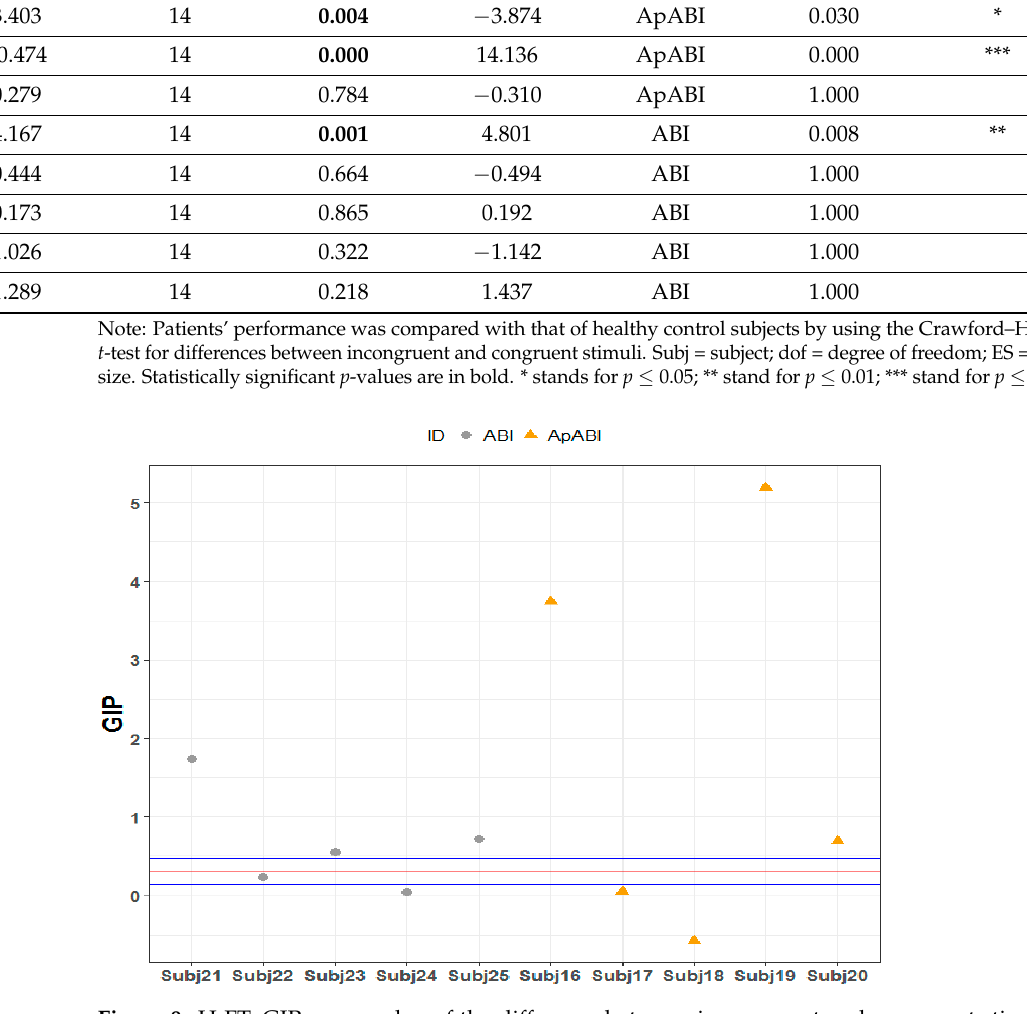
Figure 9. H-FT: GIP mean value of the difference between incongruent and congruent stimuli of each ABI patient, distributed above, below, or within the 95% confidence interval of control group. Red line = GIP mean value of the difference between incongruent and congruent stimuli of the control group; blue line = confidence limits, the two extreme values of the confidence interval which define the range.